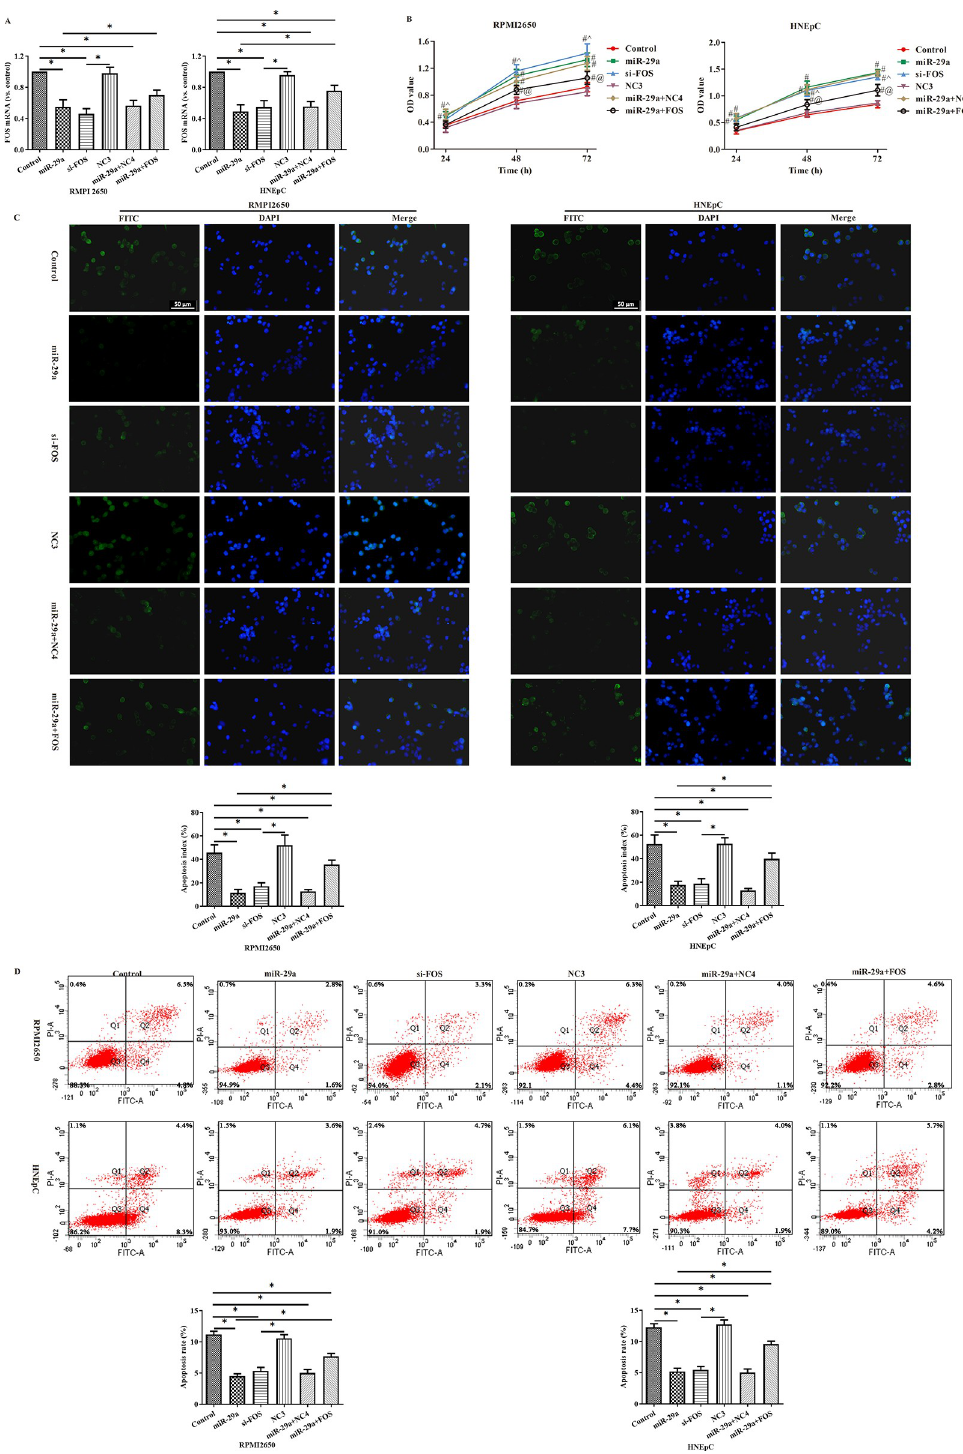
Fig 5. Mir-29a over-expression promoted the proliferation of RPMI2650 cells and HNEpC cells but inhibited their apoptosis by targeting at FOS. (A) FOS transfection efficiency was validated by PCR; (B) CCK8 assay; (C-D) flow cytometry and TUNEL assay. Compared with control group, #p < 0.05; compared with NC3 group, ^p < 0.05; compared with miR-29a group, @p < 0.05. � :p < 0.05.